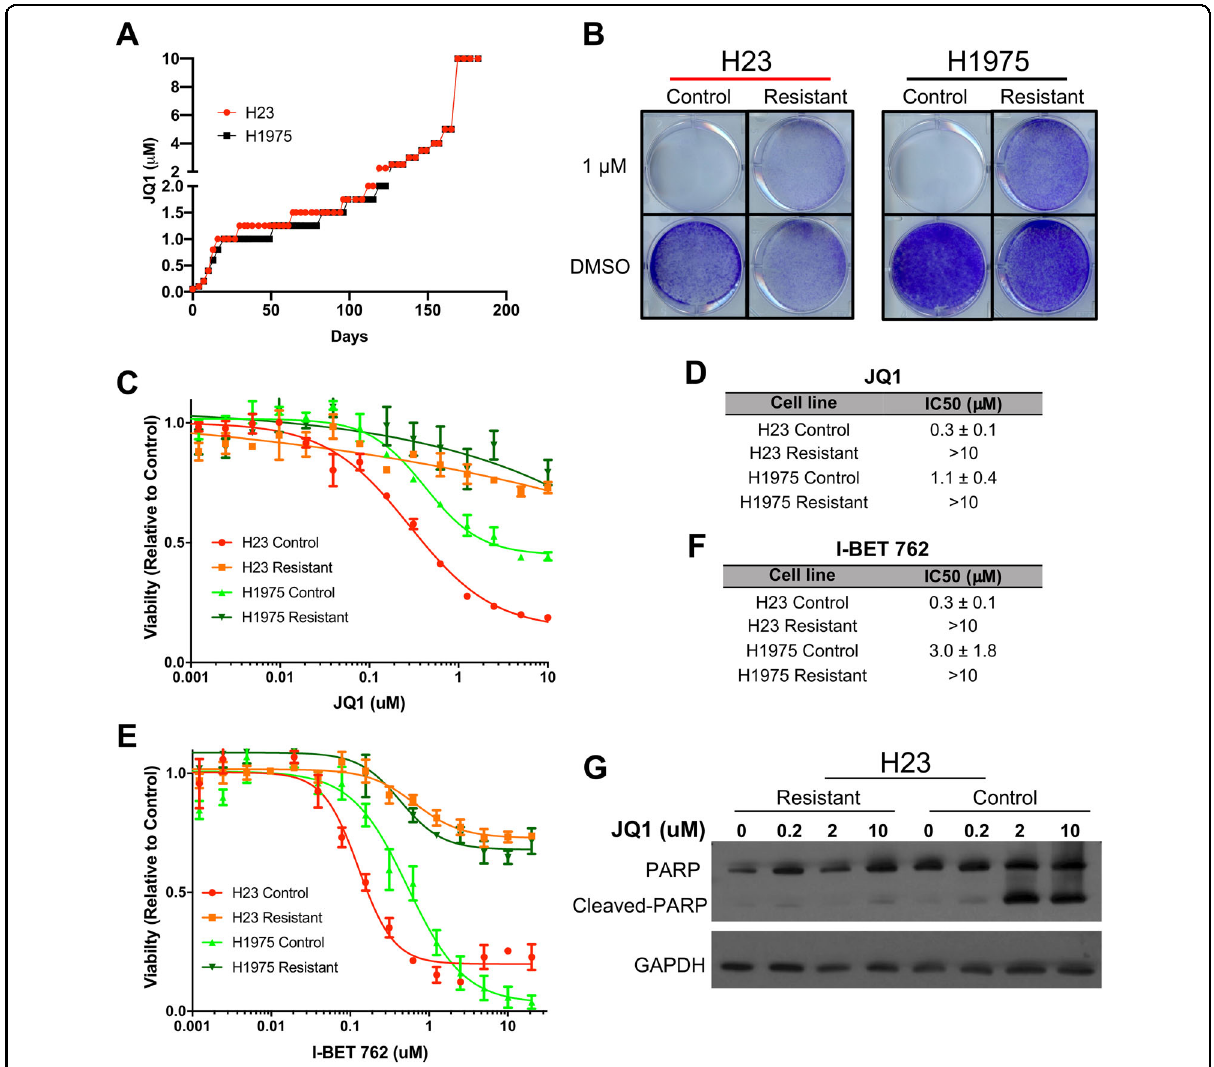
Fig. 1 Establishment of JQ1 resistant lung adenocarcinoma cell lines. A Two JQ1 sensitive LAC lines, H23 and H1975, were cultured in increasing concentrations of JQ1 media, or 0.1% DMSO media as a control, for ~6 months until cells were able to continuously grow in 10 μ M JQ1, where they were considered resistant. B Growth assays for H23 and H1975 resistant and control cell lines were performed with 1 μ M JQ1 or 0.1% DMSO over 10 days followed by crystal violet staining to assess cell viability. C Dose response experiments were performed with JQ1 over 72 h with H23 and H1975 resistant and control cell lines. Each curve is of a representative experiment with four replicate values for each dose. D JQ1 IC 50 values for each cell line are displayed from the average of four biological replicates ± standard error measure (SEM). E Representative dose response graph for I- BET762. F I-BET762 IC 50 values from three biological replicates ± SEM. G Resistant and control H23 cells were cultured in escalating doses of JQ1 for 48 h. Western blots were performed to assess apoptosis through detection of cleaved PARP with GAPDH serving as a loading